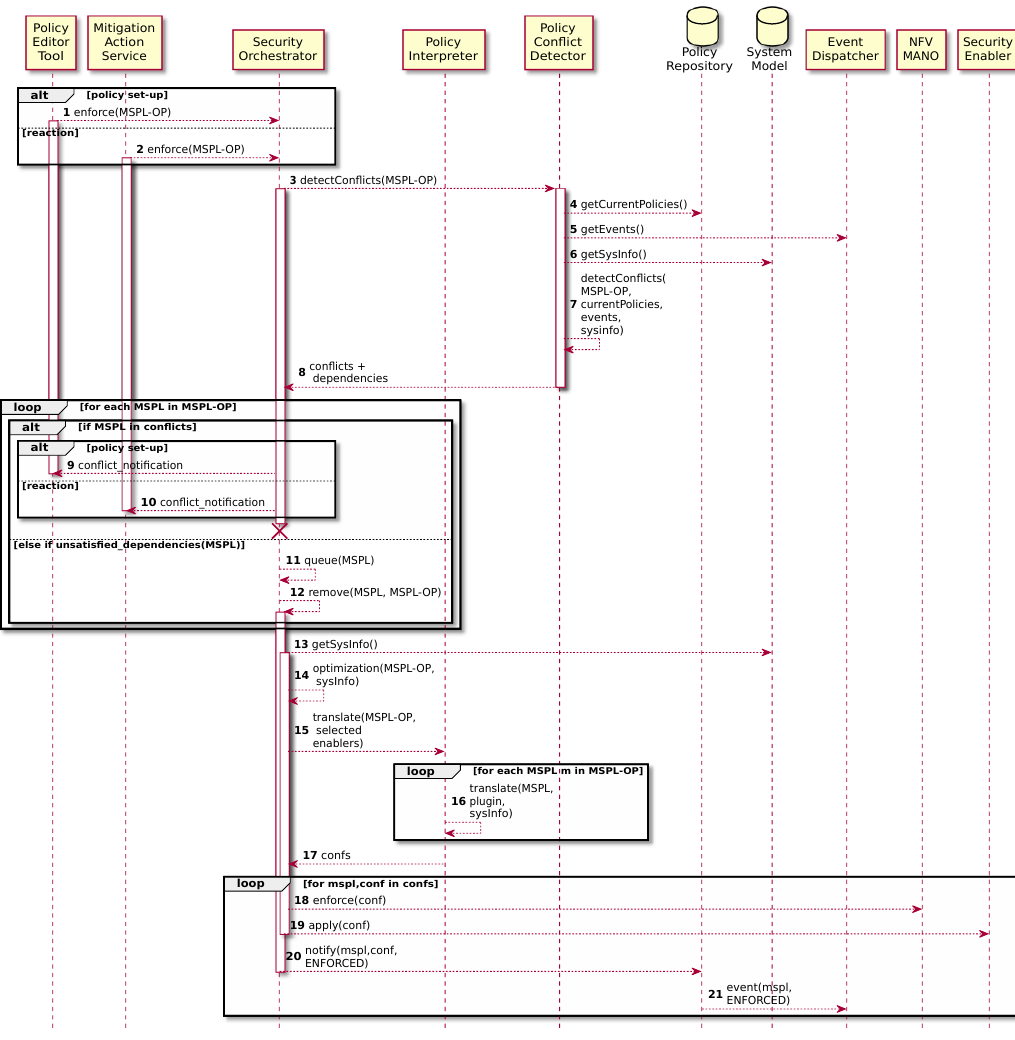
Figure 5. Policy Orchestration and Enforcement